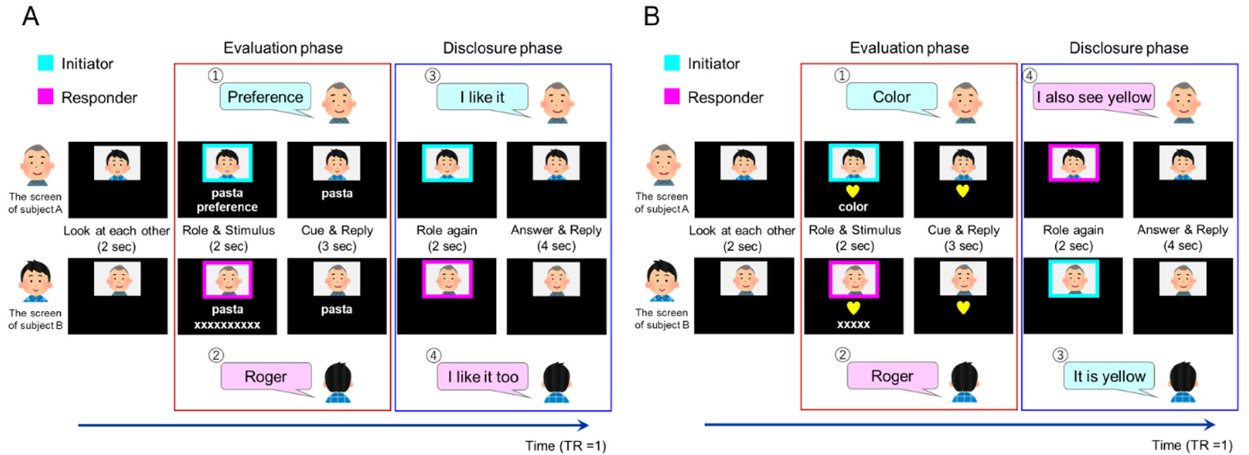
Figure 1. Time course of one trial in the ( A ) introspection task and ( B ) object feature identification task. The number in the upper left corner of the balloon indicates an example of the order of utterance. Brain activity was analyzed in the evaluation (red border) and disclosure (blue border) phases.